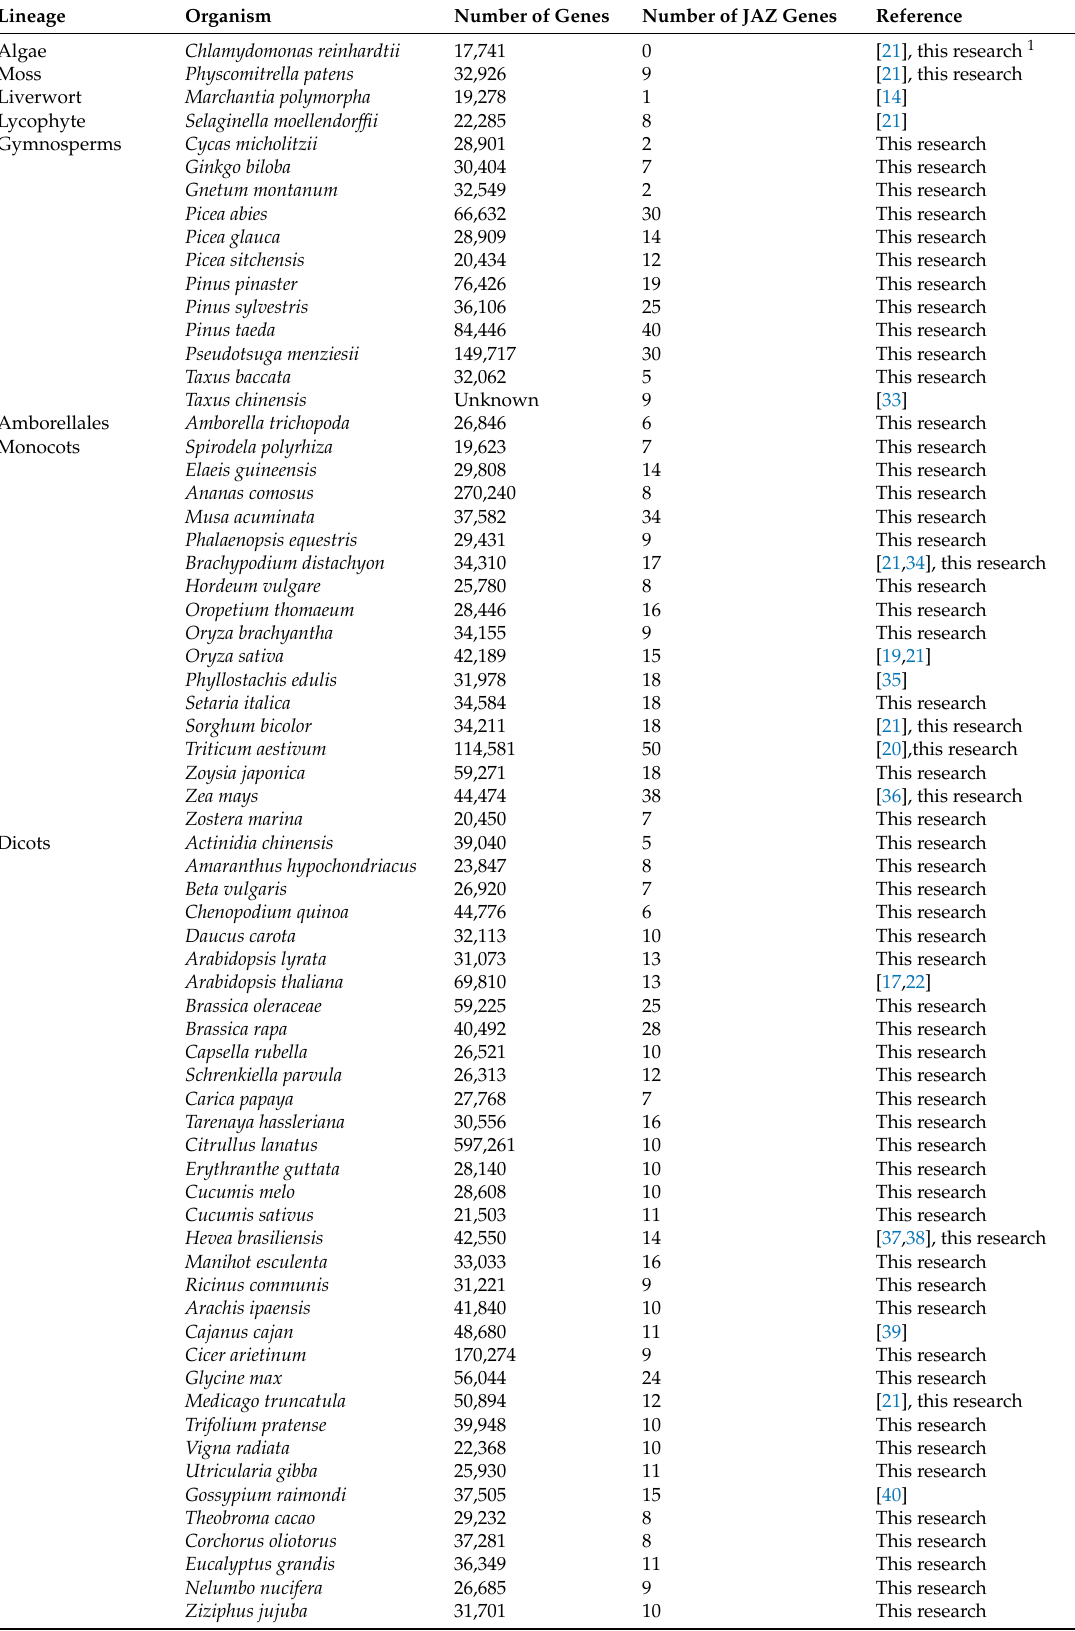
Table 1. JAZ family genes in the plant